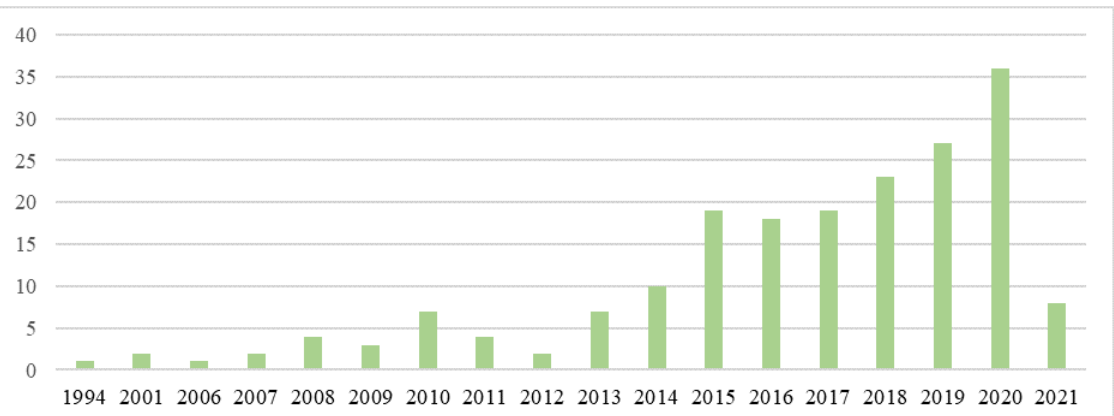
Figure 2. Publications per